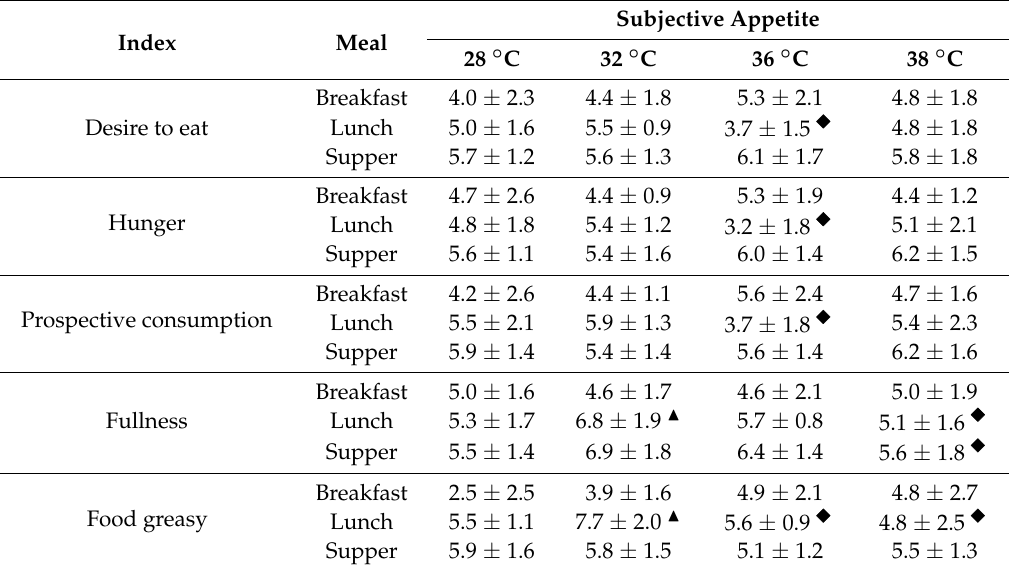
Table 6. The subjective appetite in the four temperature